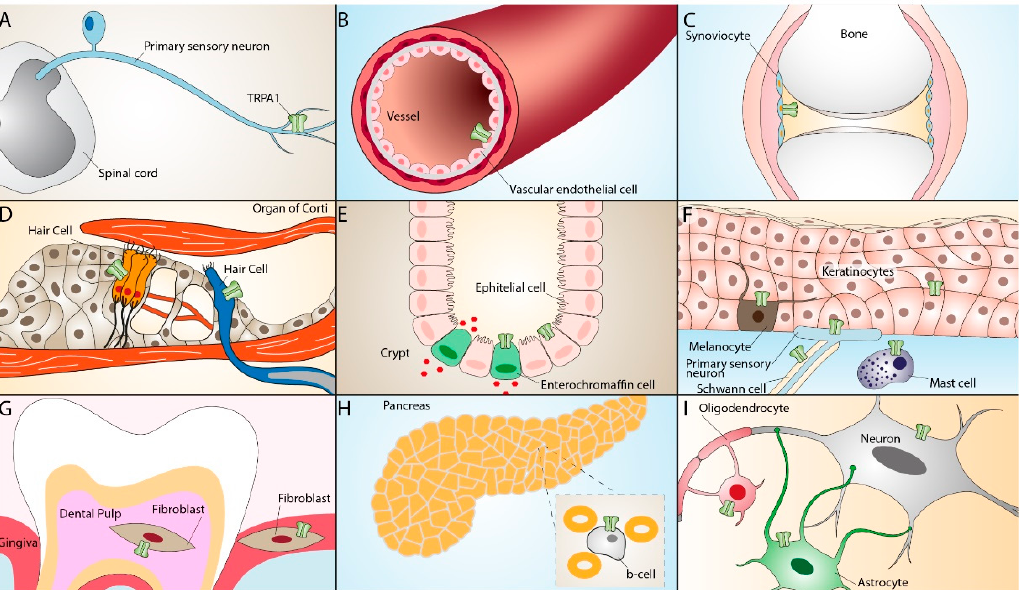
Figure 2. TRPA1 expression in neuronal and non-neuronal tissues. TRPA1 expression in primary sensory neurons ( A ), vascular endothelial cells ( B ), synoviocytes ( C ), inner ear hair cells ( D ),